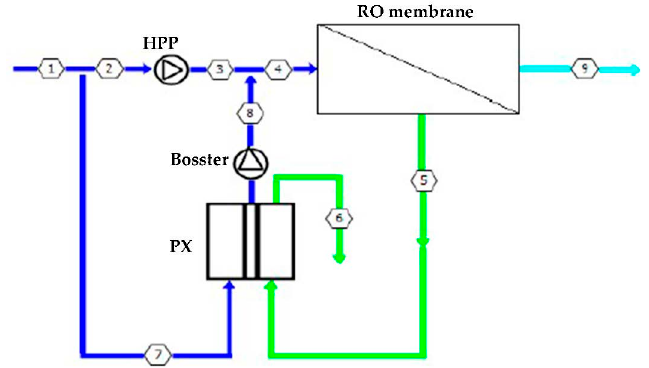
Figure 3. RO process water flow diagram.